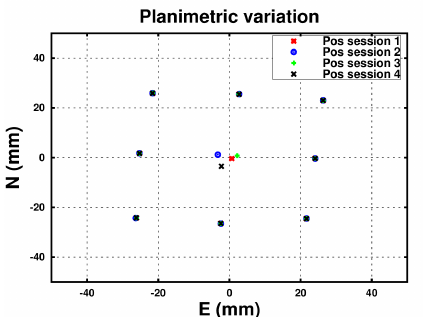
Figure 8: Planimetric variation of the antenna phase center Symbols at the center of Figure 8 represent the predictions of the antenna phase center for each session. The mean deviation between all sessions is 0 . 7 cm and the maximum deviation is 1 . 1 cm . Final values for the calibration of targets and antenna phase center positions are the average of estimated positions including all observations sessions.